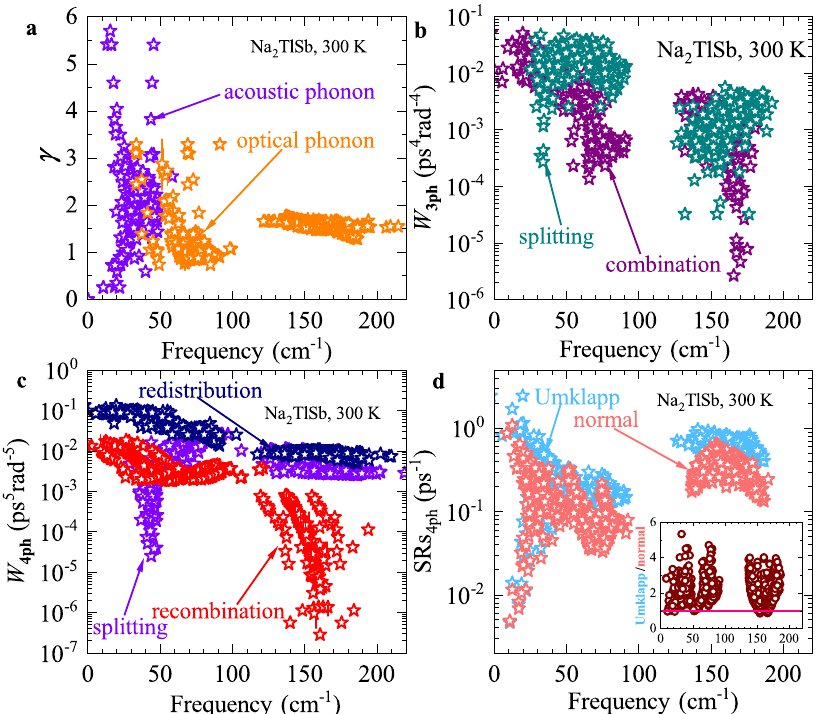
Fig. 4 Phonon scattering. a The Gr € u neisen parameter γ of acoustic (violet) and optical (orange) phonon branches. b The decomposed 3ph scattering phase space W 3ph into the splitting and combination processes. c The decomposed 4ph scattering phase space W 4 ph into the splitting, redistribution, and combination processes. d Decomposed 4ph scattering rates into the normal and Umklapp processes. The inset represents the ratios between Umklapp and normal